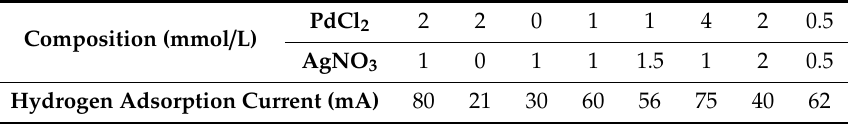
Table 1. Variations of hydrogen adsorption current values of the Pd-Ag / PPY / Ti electrodes prepared with composition of the plating solution *.